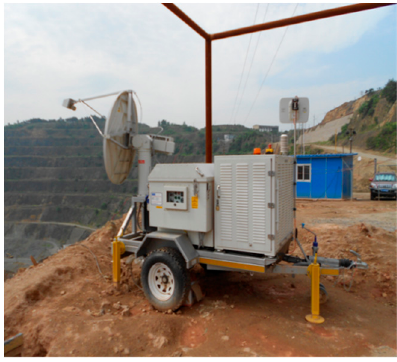
Figure 6. MSR-300 radar system.